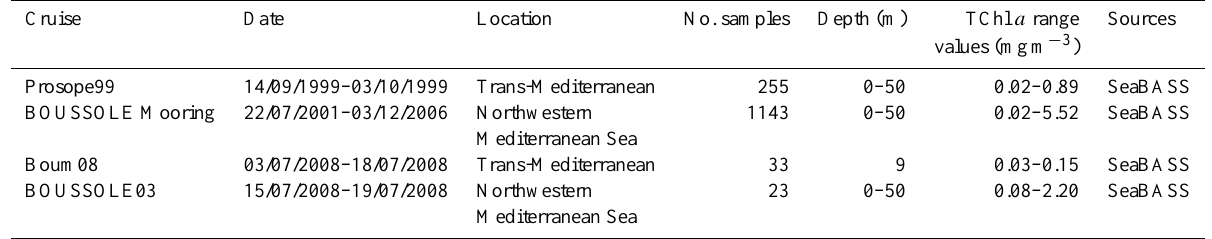
Table 1. Information about the in situ SeaBASS sub-data set used for validating of the application of the BR model on the Mediterranean